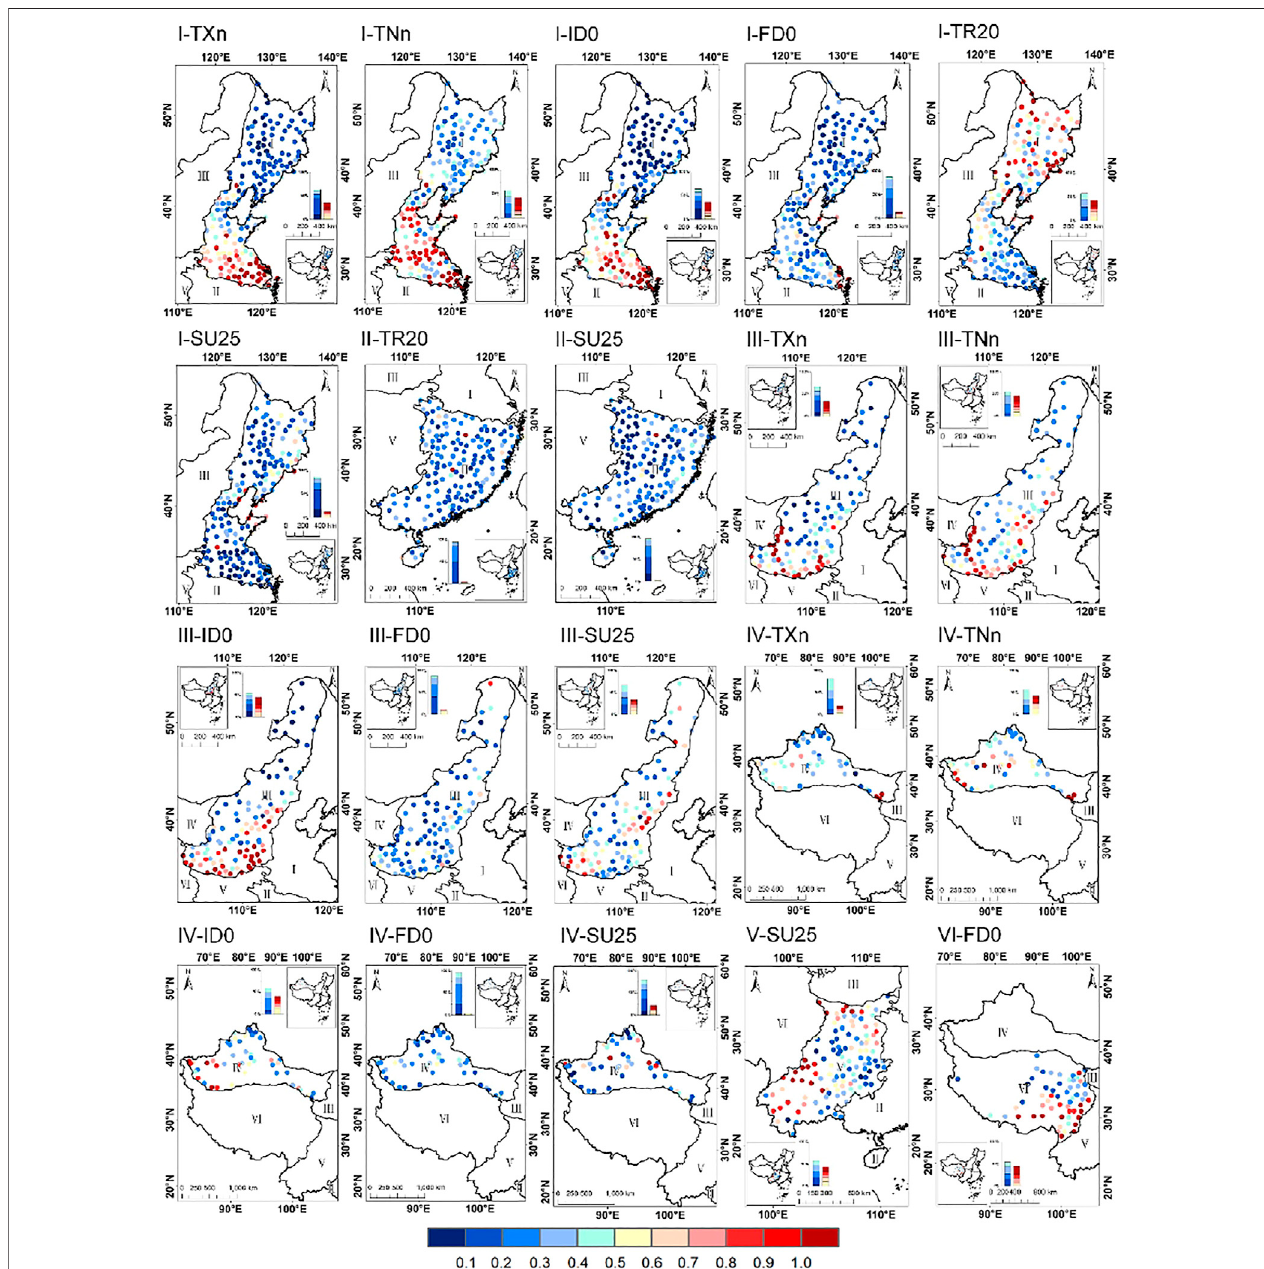
FIGURE 5 | Spatial distribution of DISO for selected extreme temperature indices of ERA5 in six regions.